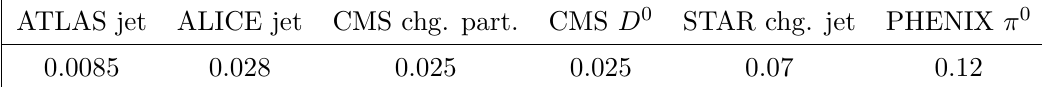
p hadron > 10 GeV/ c (green solid lines), and p hadron T